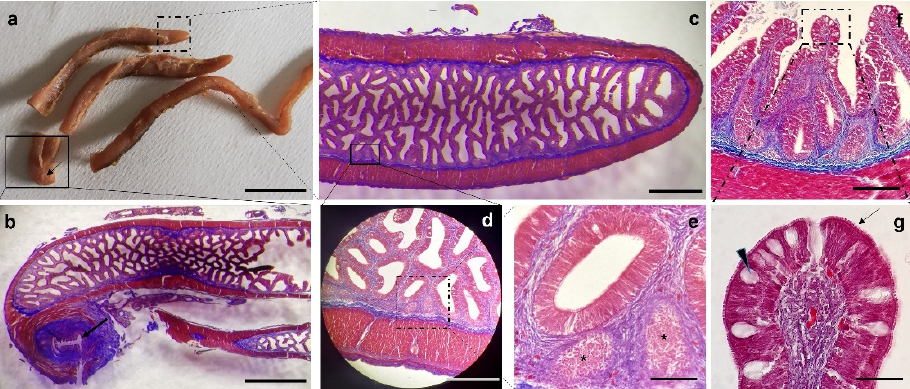
Figure 10. ( a ) Gross anatomy of the intestine and pyloric ceca. ( b – g ) Masson Trichrome with Aniline Blue staining. ( b ) Stereomicrographs of a sagittal section of pyloric ceca: pyloric ostium (arrow). ( c ) Stereomicrograph of a longitudinal section of the pyloric cecum with a labyrinthine aspect. ( d , e ) longitudinal section of the pyloric cecum: masses of lymphoid tissue in the mucosal lamina propria (dotted area and asterisks). ( f ) Light micrograph of the pyloric cecum in transversal section. ( g ) transversal section of pyloric cecum: microvilli (arrow) and goblet cells (arrowhead). Scale bar: 1 cm ( a ), 1 mm ( b ), 500 μ m ( c ), 100 μ m ( d ), 50 μ m ( e – g ).